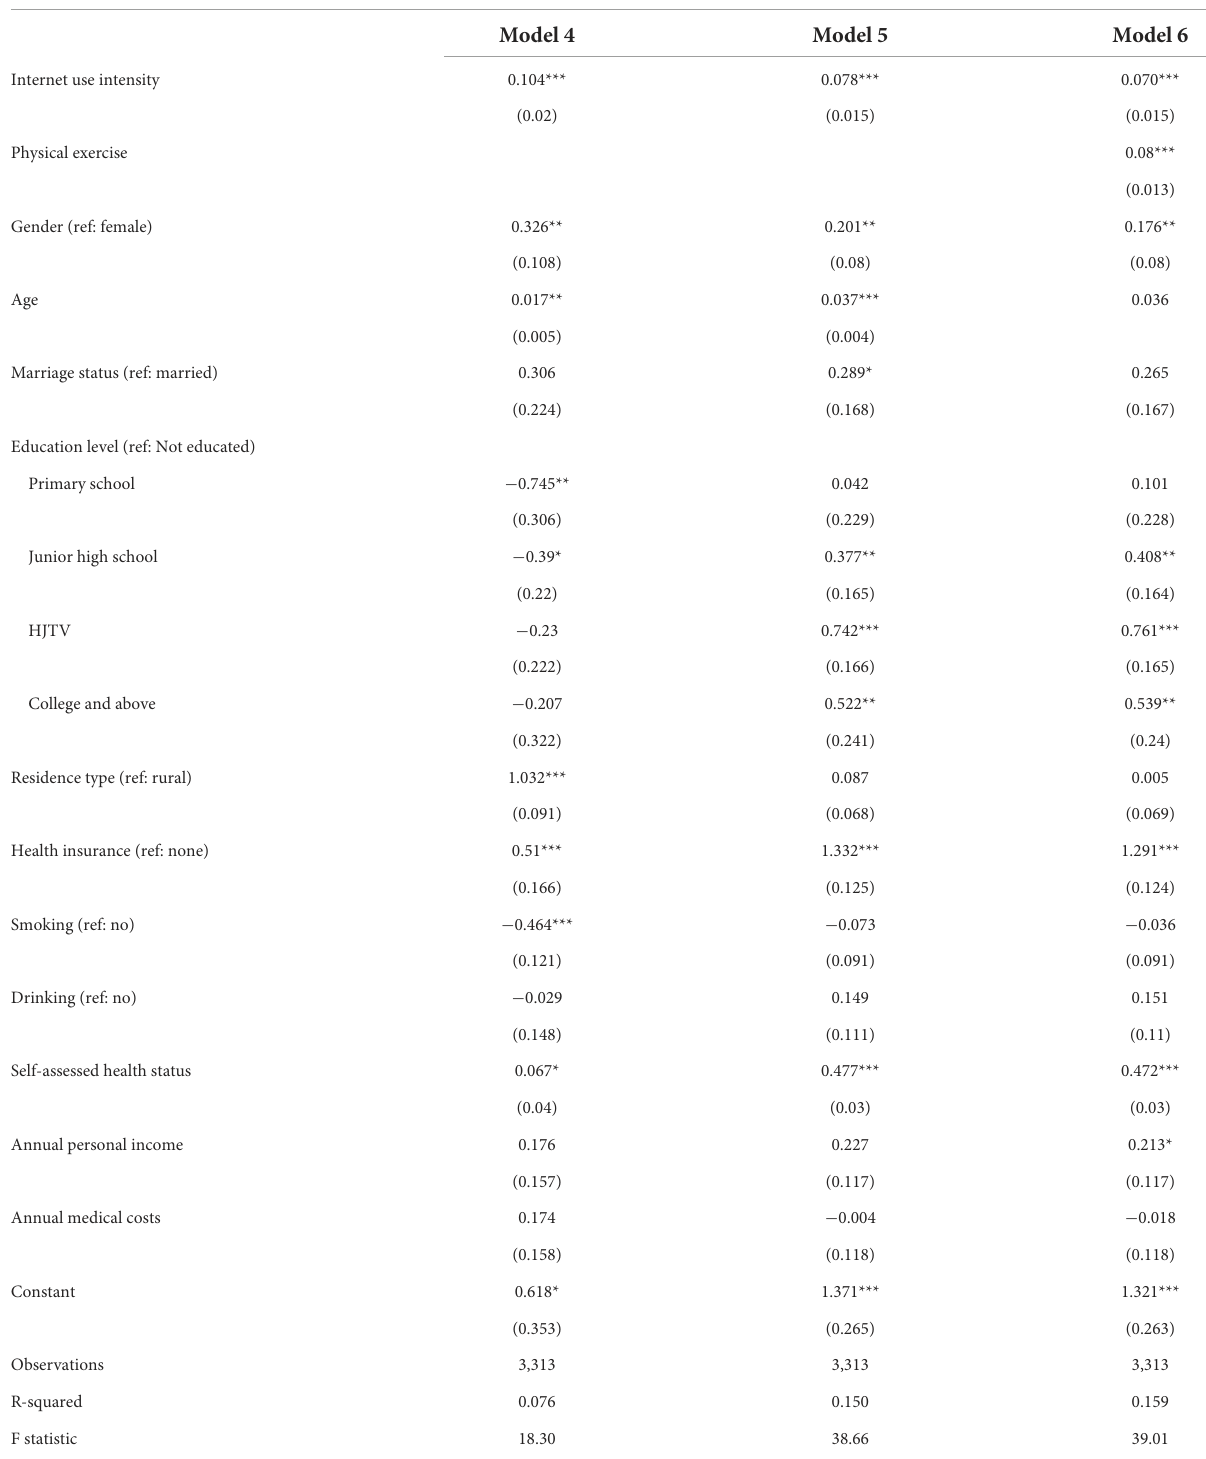
TABLE 4 Results of the mediating effect test ( N =